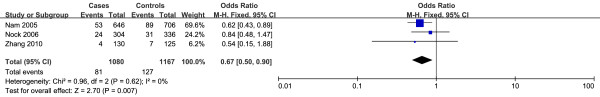
Forest plots for hOGG1 Ser326Cys polymorphism and risk of Prostate cancer in mixed population (Cys/Cys versus Ser/Ser). The squares and horizontal lines correspond to the study specific OR and 95% CI. The area of the squares reflects the weight (inverse of the variance). The diamond represents the summary OR and 95% CI.